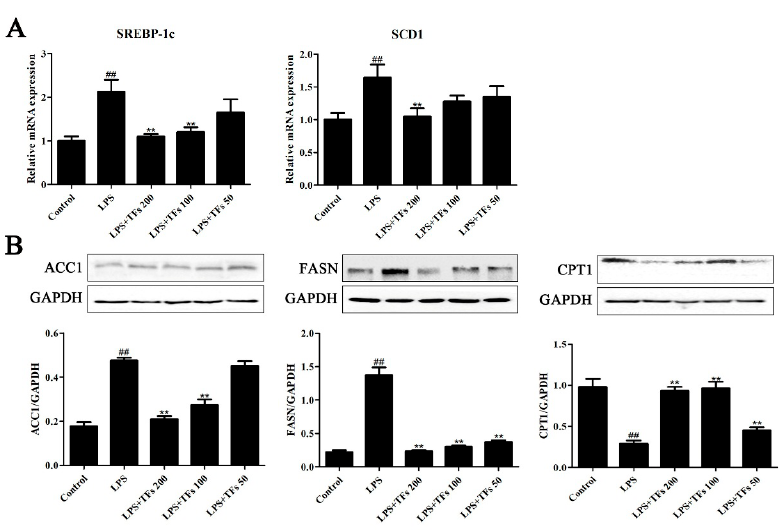
Figure 6. TFs regulated FXR-SREBP-1c-mediated lipid metabolism. ( A ) Effects of TFs on the mRNA levels of SREBP-1c and SCD1 on the basis of real-time PCR assay. ( B ) Effects of TFs on the expression levels ofACC1 (acetyl-CoA carboxylase-1), FASN (fatty acid synthase), and CPT1 (carnitine palmitoyltransferase 1) on the basis of the western blotting assay. The values are expressed as the mean ± SD ( n = 3); ## p < 0.01 versus control group; ** p < 0.01 versus model.